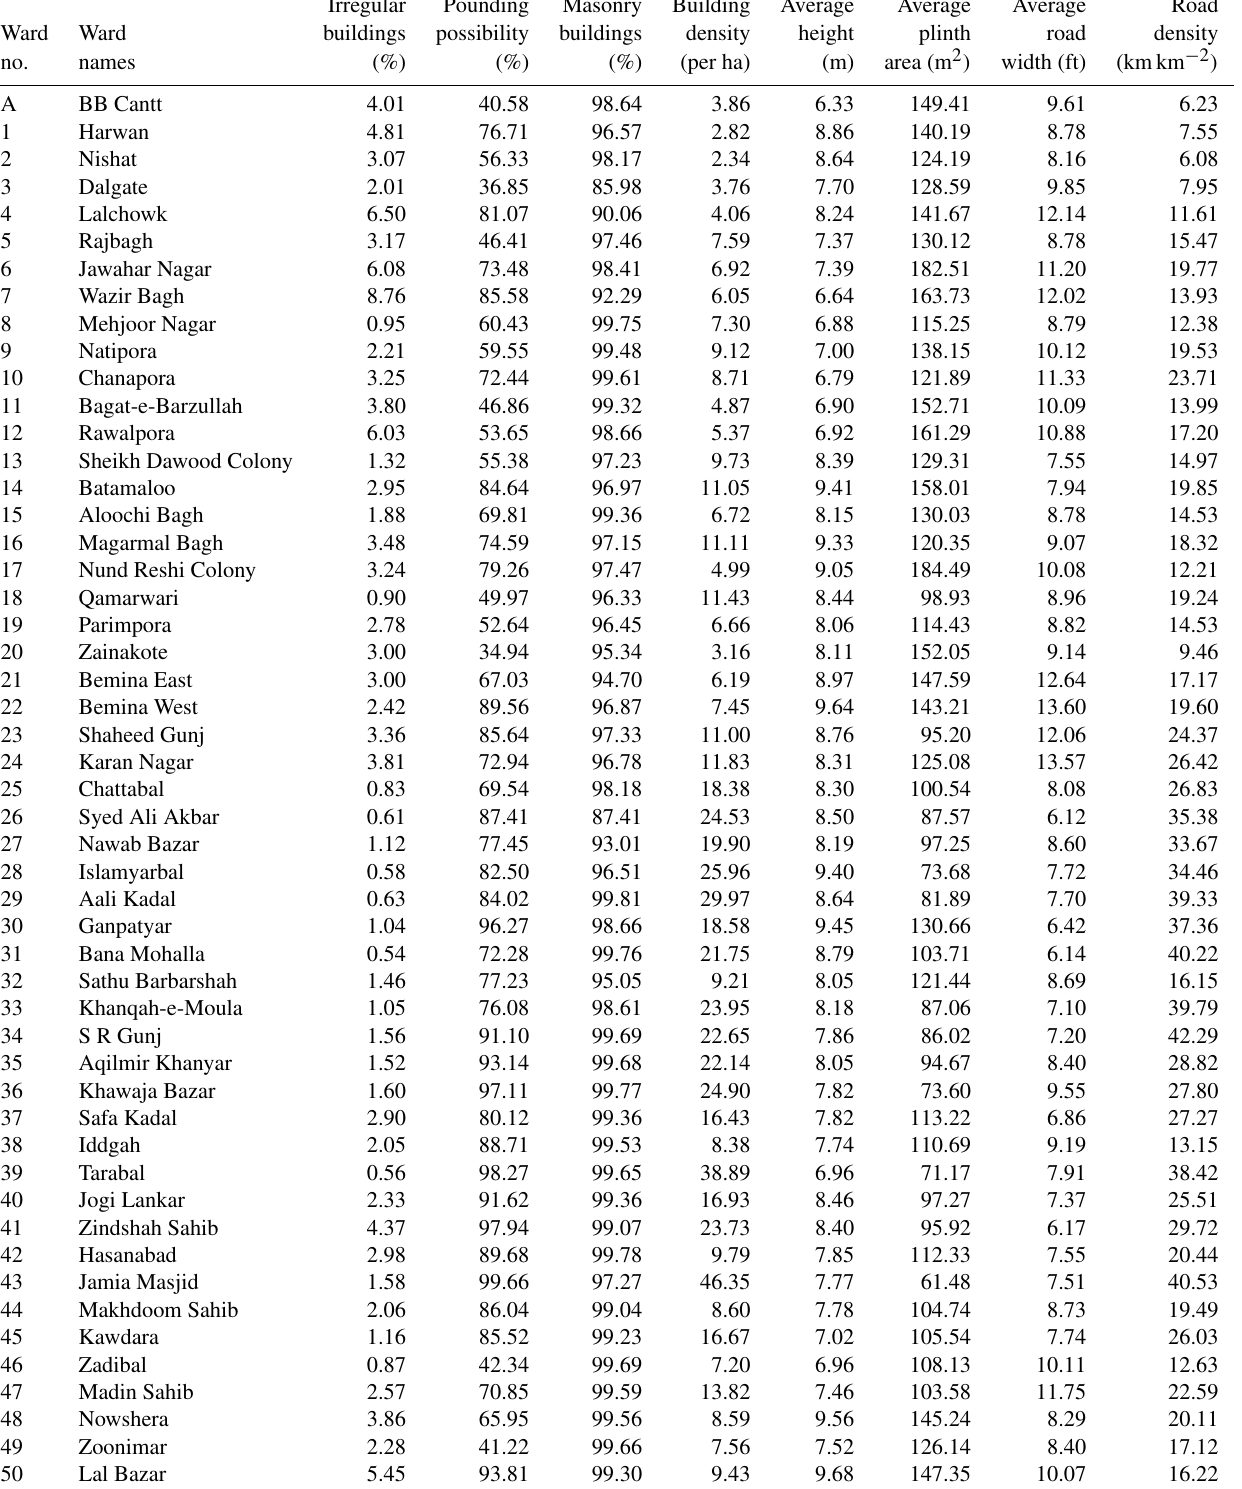
Table 6. Ward-wise built-up parameters used for vulnerability assessment of the city of Srinagar. Irregular Pounding Masonry Building Average Average Average Road Ward Ward buildings possibility buildings density height plinth road